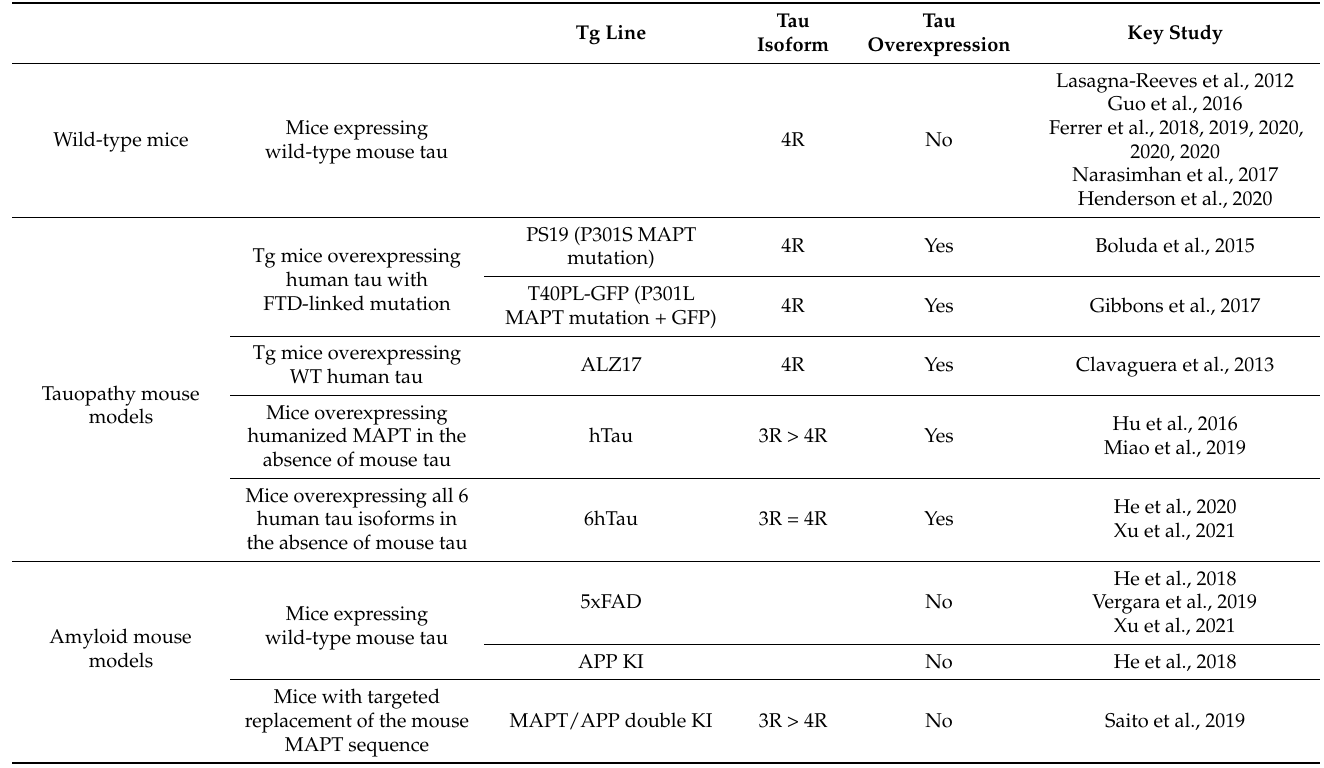
Table 1. Summary table of the key studies involving injection of patient-derived tau fibrils in different mouse models.